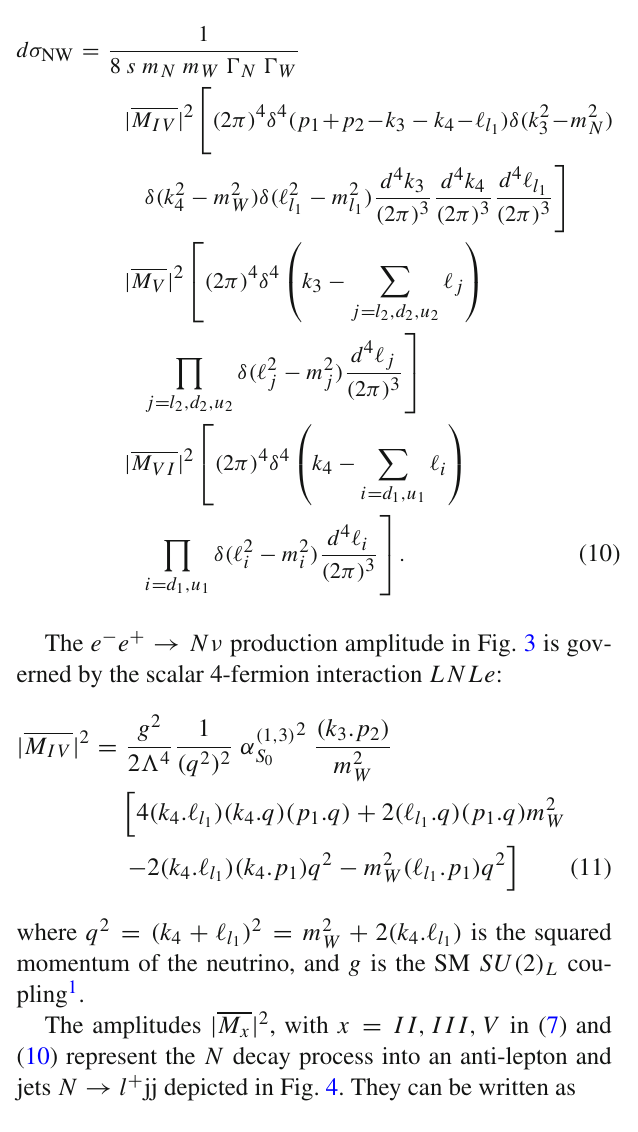
The differential cross section for the single N process in Fig. 3 can be decomposed as a product,